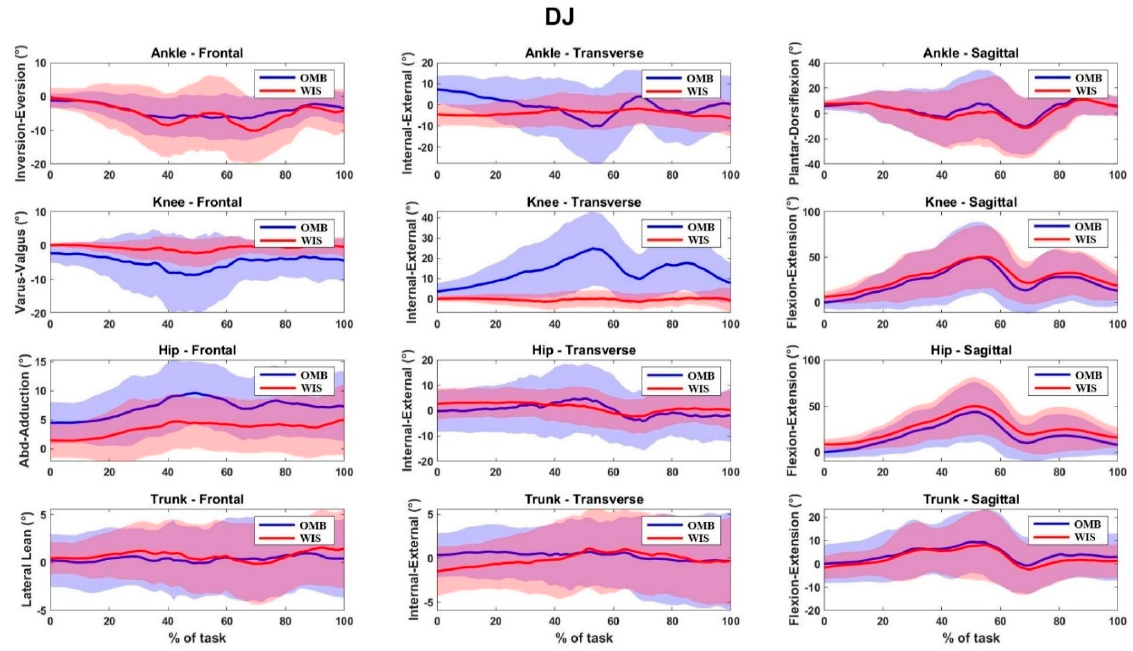
Figure A2. Joint kinematics of marker-based (OMB, blue) and inertial sensors (WIS, red) for the drop jump (DJ) task. Data are normalized by the length of the motor task. The waveforms are shown as average (solid lines) and standard deviations (shaded lines).